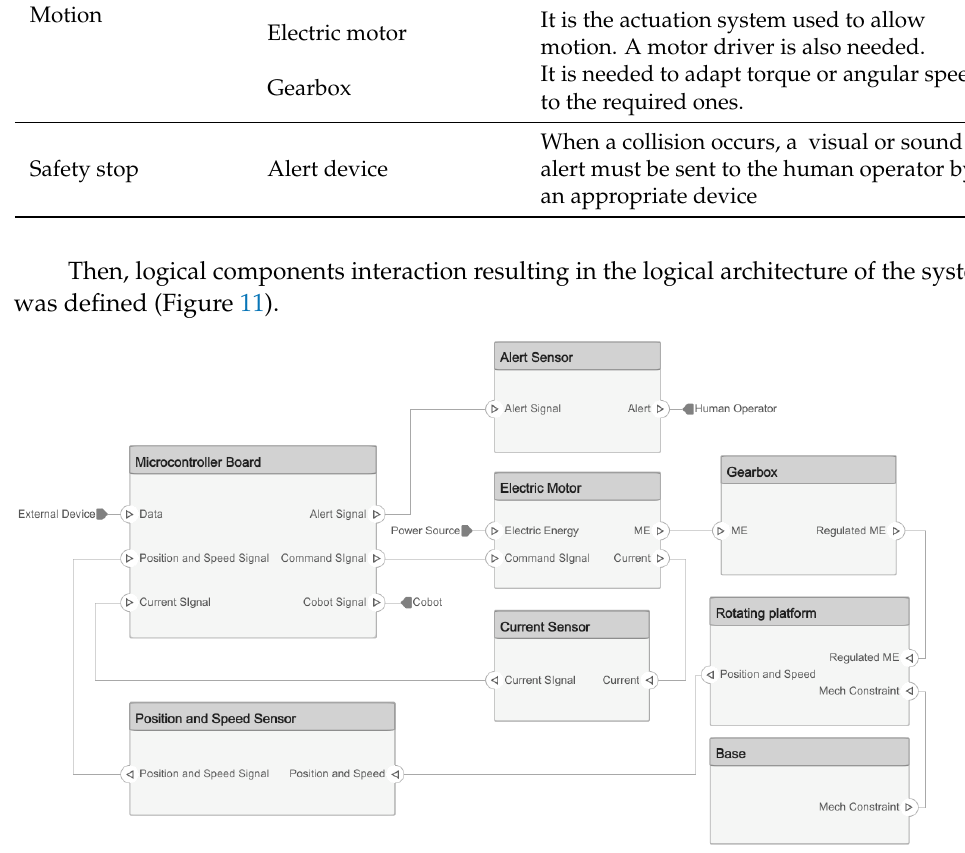
Figure 11. Logical architecture modeled using System